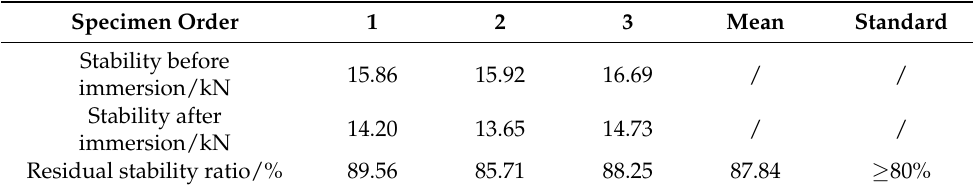
Table 12. Marshall specimen residue